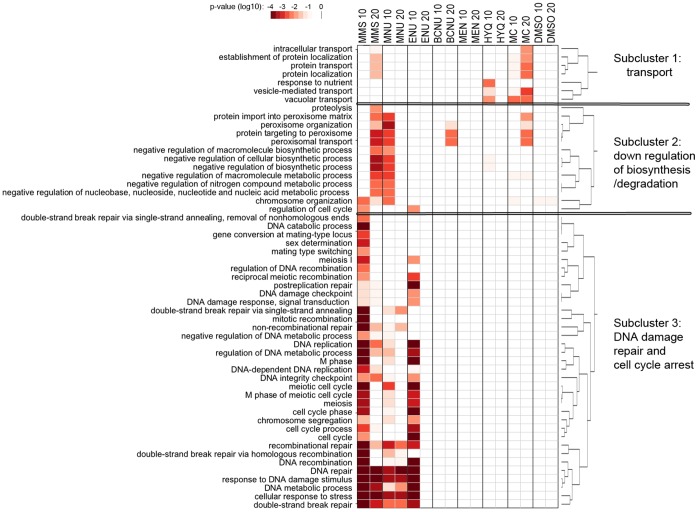
Functional enrichment reveals an alkylating agent-specific DNA repair and cell cycle dependency.Gene-annotation enrichment analysis heat map and clustering for sensitive strains to different compounds at early (10 generation times) or late (20 generation times) timepoints. Heat map colors correspond to the –log10 of the p-values.